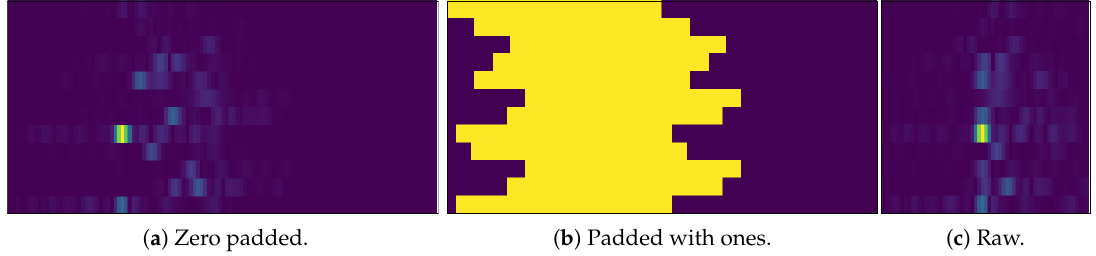
Figure 12. Overview: From raw data to zero padded to padded with